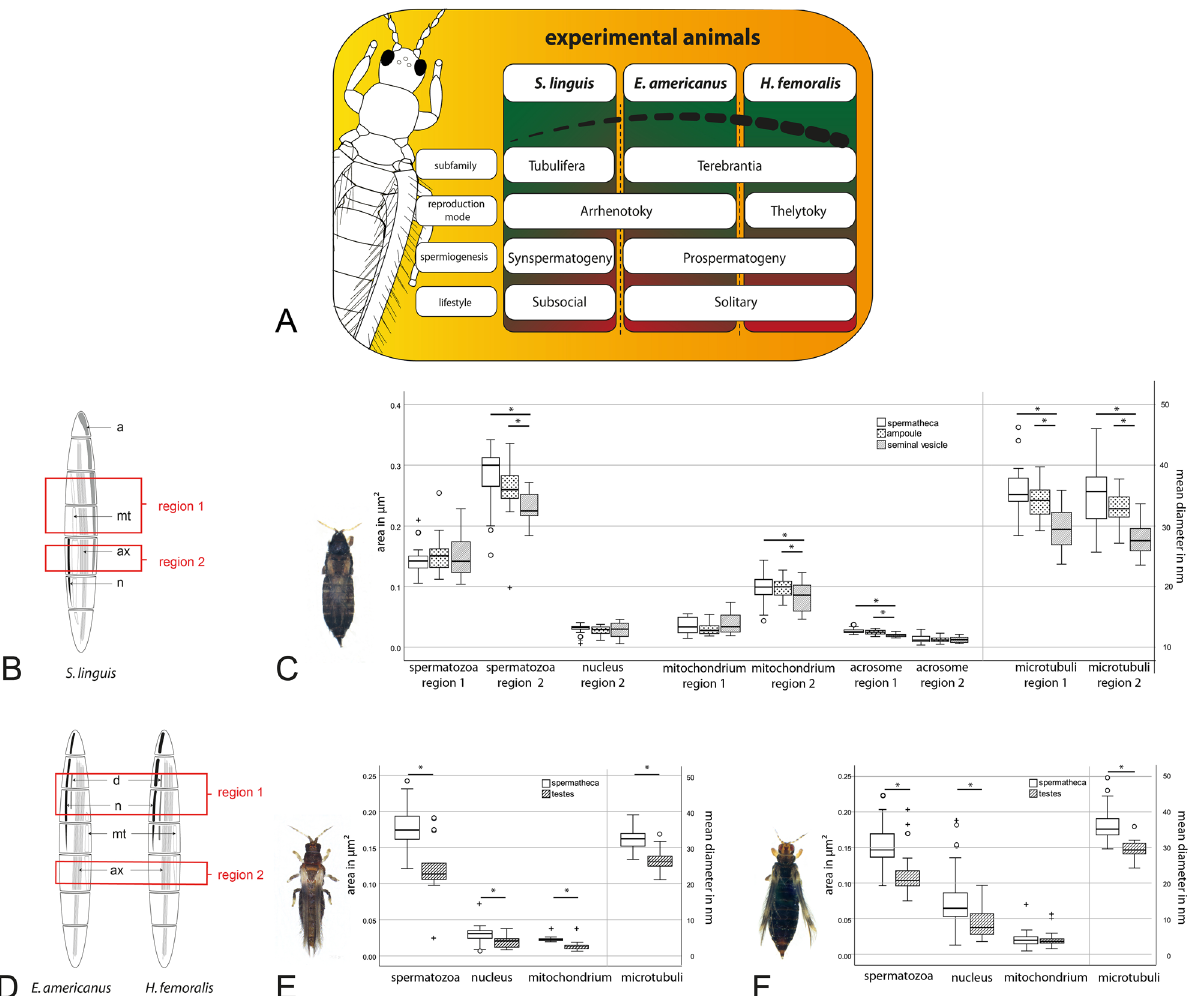
Figure 5. Comparison of the ultrastructure of the spermatozoa in the testes/seminal vesicle and the spermatheca/ampoule. ( A ) overview of the experimental animals and characteristics; ( B , D ) Overview of the sperm ultrastructure of the three species from anterior to posterior. by Krueger & Moritz 2021, used under CC by 4.0 /Distance, labelling and marking changed. The regions marked were selected for detailed measurements and comparison between the structure of spermatozoa obtained from males and females; ( C ) Suocerathrips linguis , measurements of the organelles within the different regions and origins, (n (sptc) = 34, n(amp) = 52, n(seminal vesicle) = 28); ( E ): Echinothrips americanus , (n(sptc) = 98, n(testes) = 24); ( F ) Hercinothrips femoralis , (n(sptc) = 79, n(testes) = 17); * indicate significant differences, (A: Kruskal–Wallis -test, p ≤ 0.05, B/C: Mann– Whitney U-test, p ≤ 0.05), ○ and + indicate (extreme)